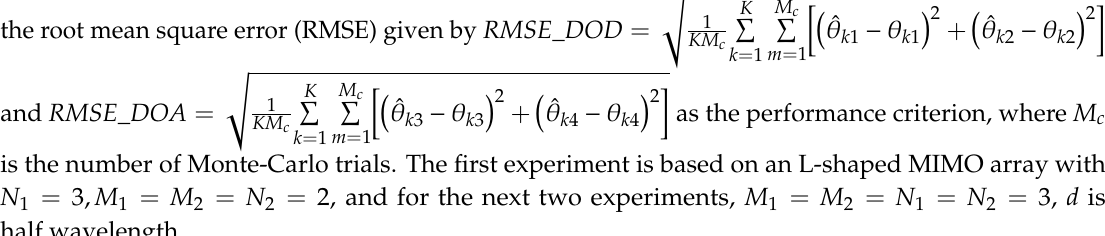
Figure 5. 2D-DOA scattergram of six mixed signals. Experiment 2. In the second experiment, the performance of the proposed algorithm is investigated with SNR varying from -5dB to 15dB. We consider four uncorrelated mixed signals with direction